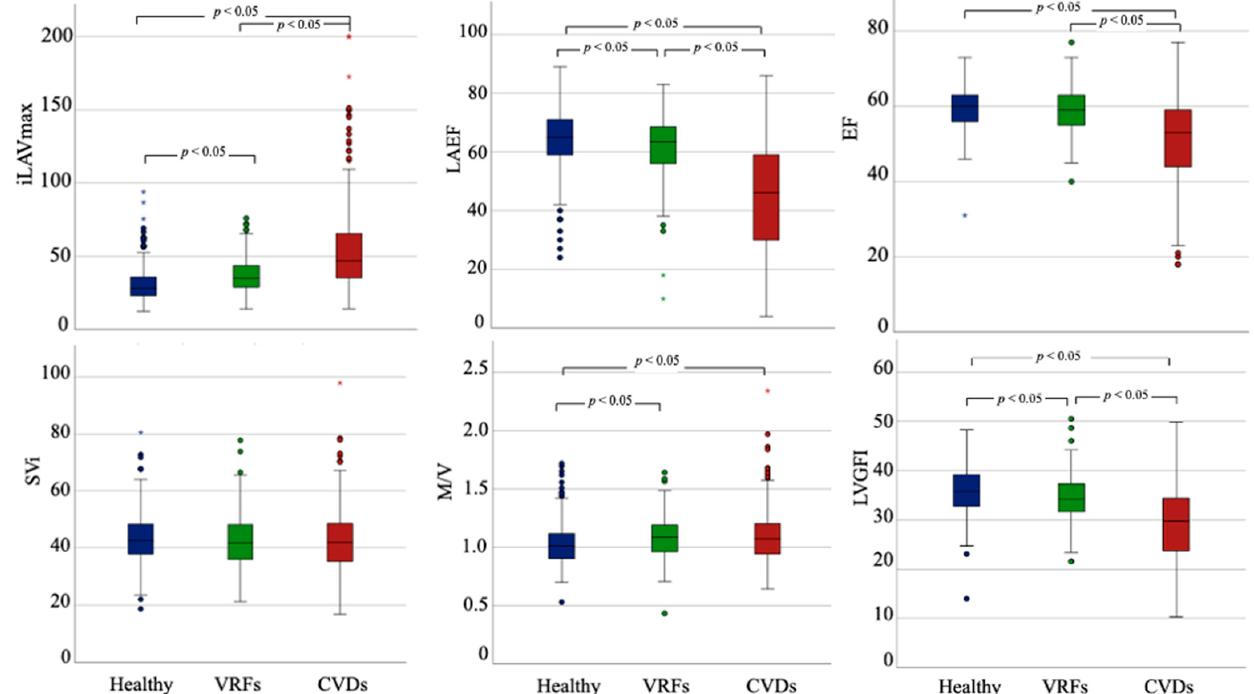
Figure 1. Three-dimensional (3D)-DHM echocardiographic metrics stratified according to the presence of VRFs and CVDs. LAEF = left atrial ejection fraction; LAVi = left atrial volume indexed, LVGFI = left ventricle global function index, M/V = left ventricular mass/left ventricular end- diastolic volume ratio, Svi = stroke volume indexed.